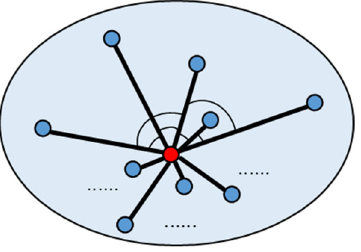
Figure 2. Schematic diagram for 3D Feature Index.